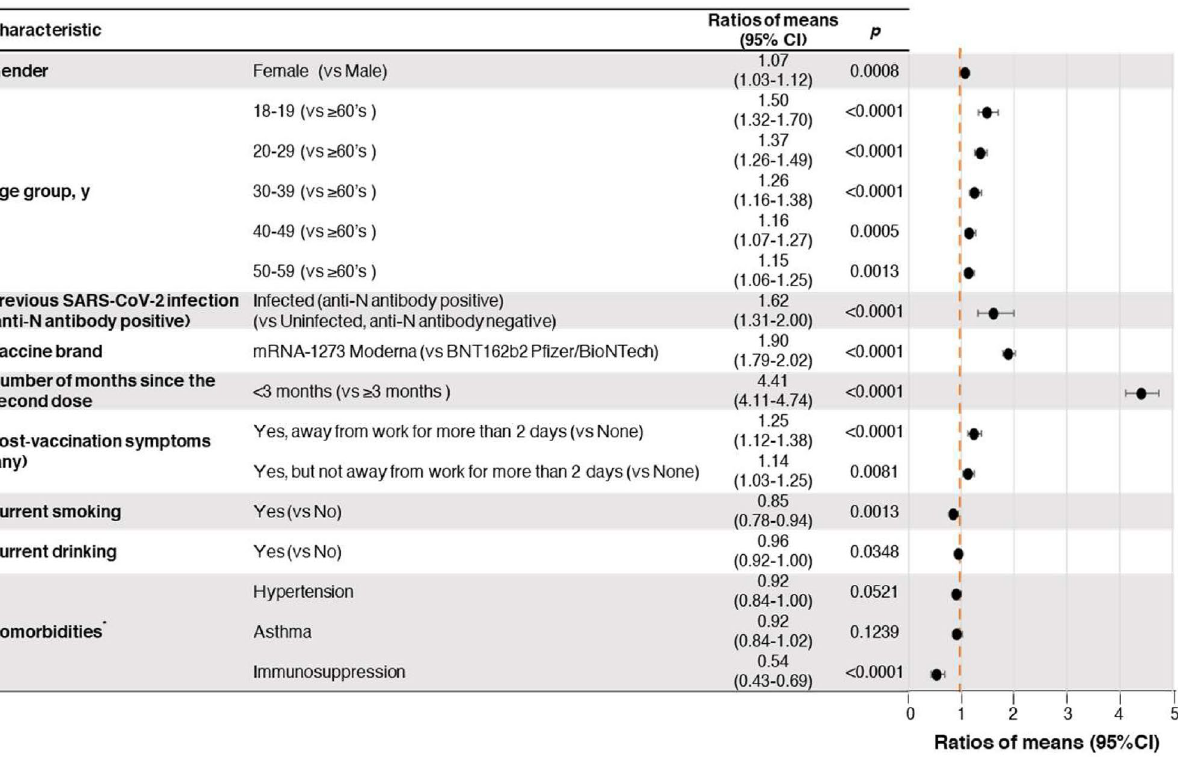
Figure 2. Multivariate linear regression results for anti-spike (S) protein IgG antibody titers after the second dose of mRNA COVID-19 vaccine. Model P < 0.0001, R 2 = 0.7542. *Comorbidities with fewer than 20 participants (heart disease, stroke, chronic obstructive lung disease, renal failure requiring dialysis, cancer) were excluded from the analysis. Variables were selected using the stepwise method ( P < 0.25). SARS-CoV-2 severe acute respiratory syndrome coronavirus 2, RoM ratios of means, CI confidence interval, IgG immunoglobulin